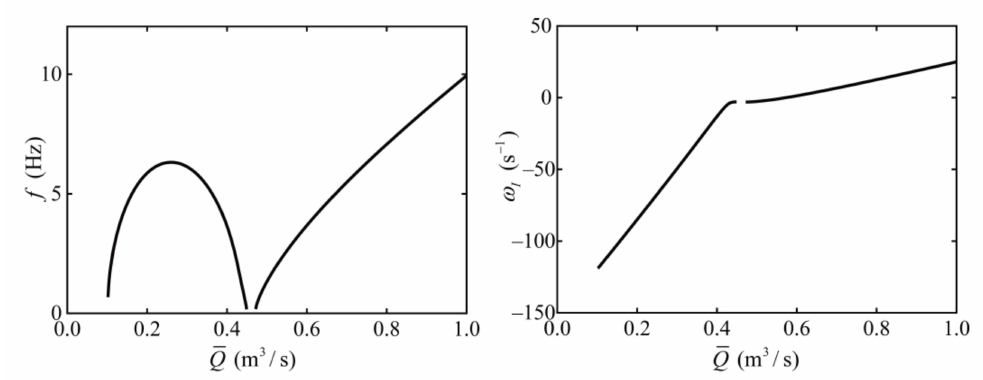
Figure 16. Frequencies ( left ) and increments ( right ) of the cavity oscillations. Parameter α is calcu- lated by Equation (15) and C is calculated by Equation (16).